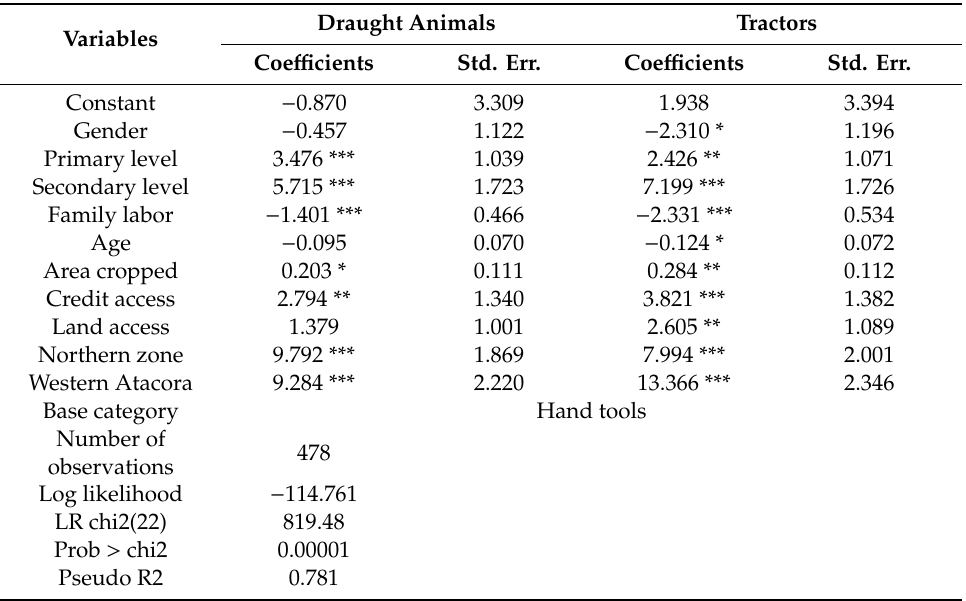
Table 4. Estimation of the multinomial Logit model of the farm mechanization drivers.